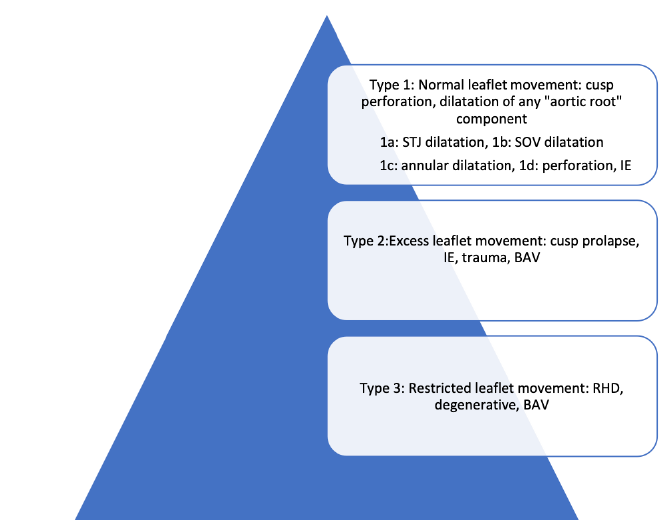
Fig. 1 - Classification of aortic regurgitation. BAV=bicuspid aortic valve; IE=infective endocarditis; RHD=rheumatic heart disease; SOV=sinus of Valsalva; STJ=sinotubular